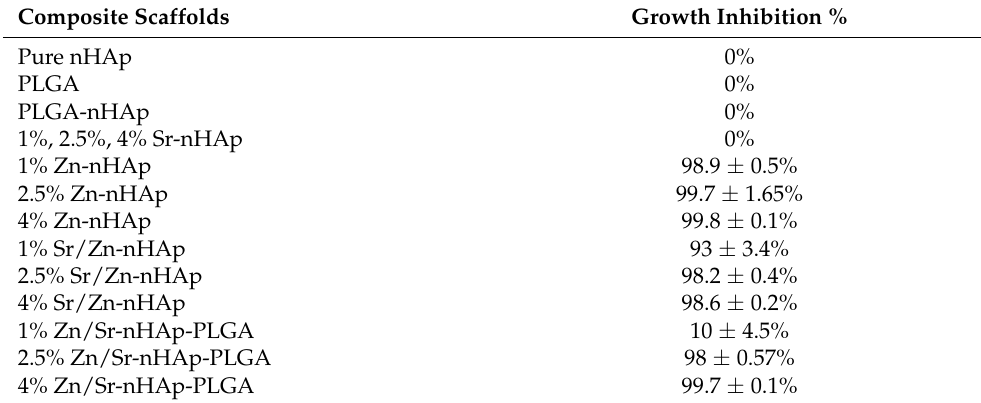
Table 2. Bacterial growth inhibition percentage for different scaffolds ± SEM. Composite